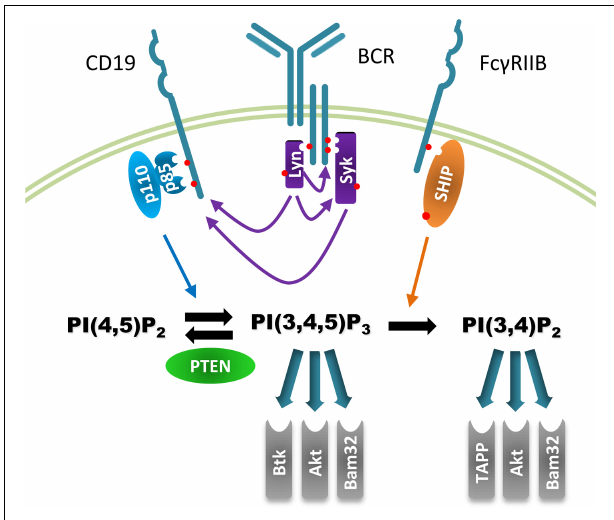
FIGURE 1 | Major components of the PI3K pathway in B cells discussed in this review. PI3K pathway activation via B cell antigen receptor is depicted schematically. Lyn and Syk are recruited to the engaged BCR where they are activated by phosphorylation and initiate the downstream signaling cascade. Class I PI3K such as p110 δ or p110 α binds phosphorylated CD19 and catalyzes the production of PIP 3 . Alternative PI3K recruitment mechanisms not shown include binding to BCAP,TC21, or IRS-2/IL-4R. Several PH domain-containing signaling proteins bind to PIP 3 including enzymes such as Btk and Akt and adaptor proteins such as Bam32. PIP 3 levels are down-regulated by phosphatases PTEN and SHIP. PTEN directly opposes the PI3K reaction while SHIP, classically activated downstream of Fc γ RIIB co-aggregation with the BCR, produces a novel second messenger PI(3,4)P 2 which can recruit its own set of PH domain proteins. Recruited PI-binding proteins are enzymatically activated